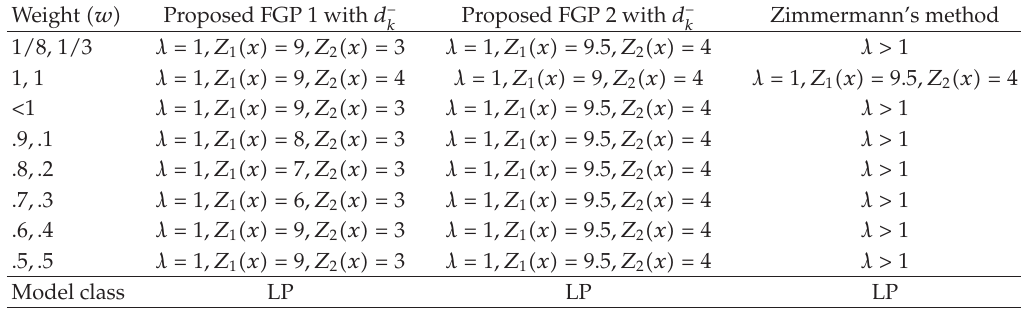
Table 8: Solution and comparison.